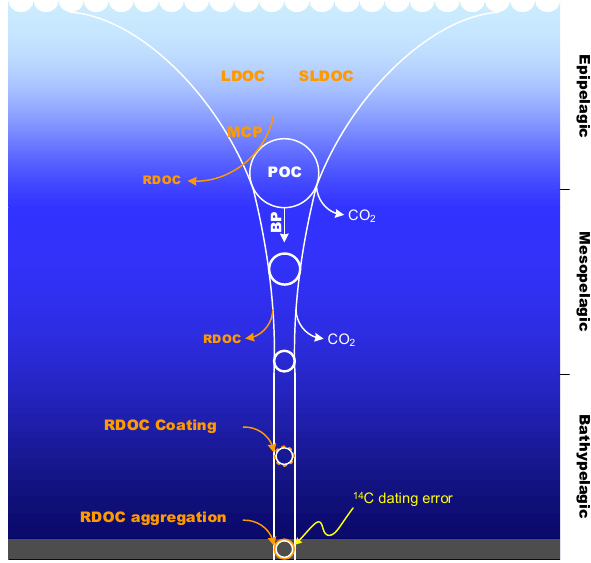
Figure 2. Transformation of DOC and POC through decomposition and scavenging processes that could influence carbon sequestration and 14 C dating (see text for details). MCP – microbial carbon pump, BP – biological pump, POC – particulate organic carbon, DOC – dissolved organic carbon, LDOC – labile DOC, SLDOC – semi- labile DOC, RDOC – refractory DOC, RDOC coating – the process of RDOC attaching to the exterior of or being incorporated into a particle, RDOC aggregation – the process of RDOC molecules accumulating and